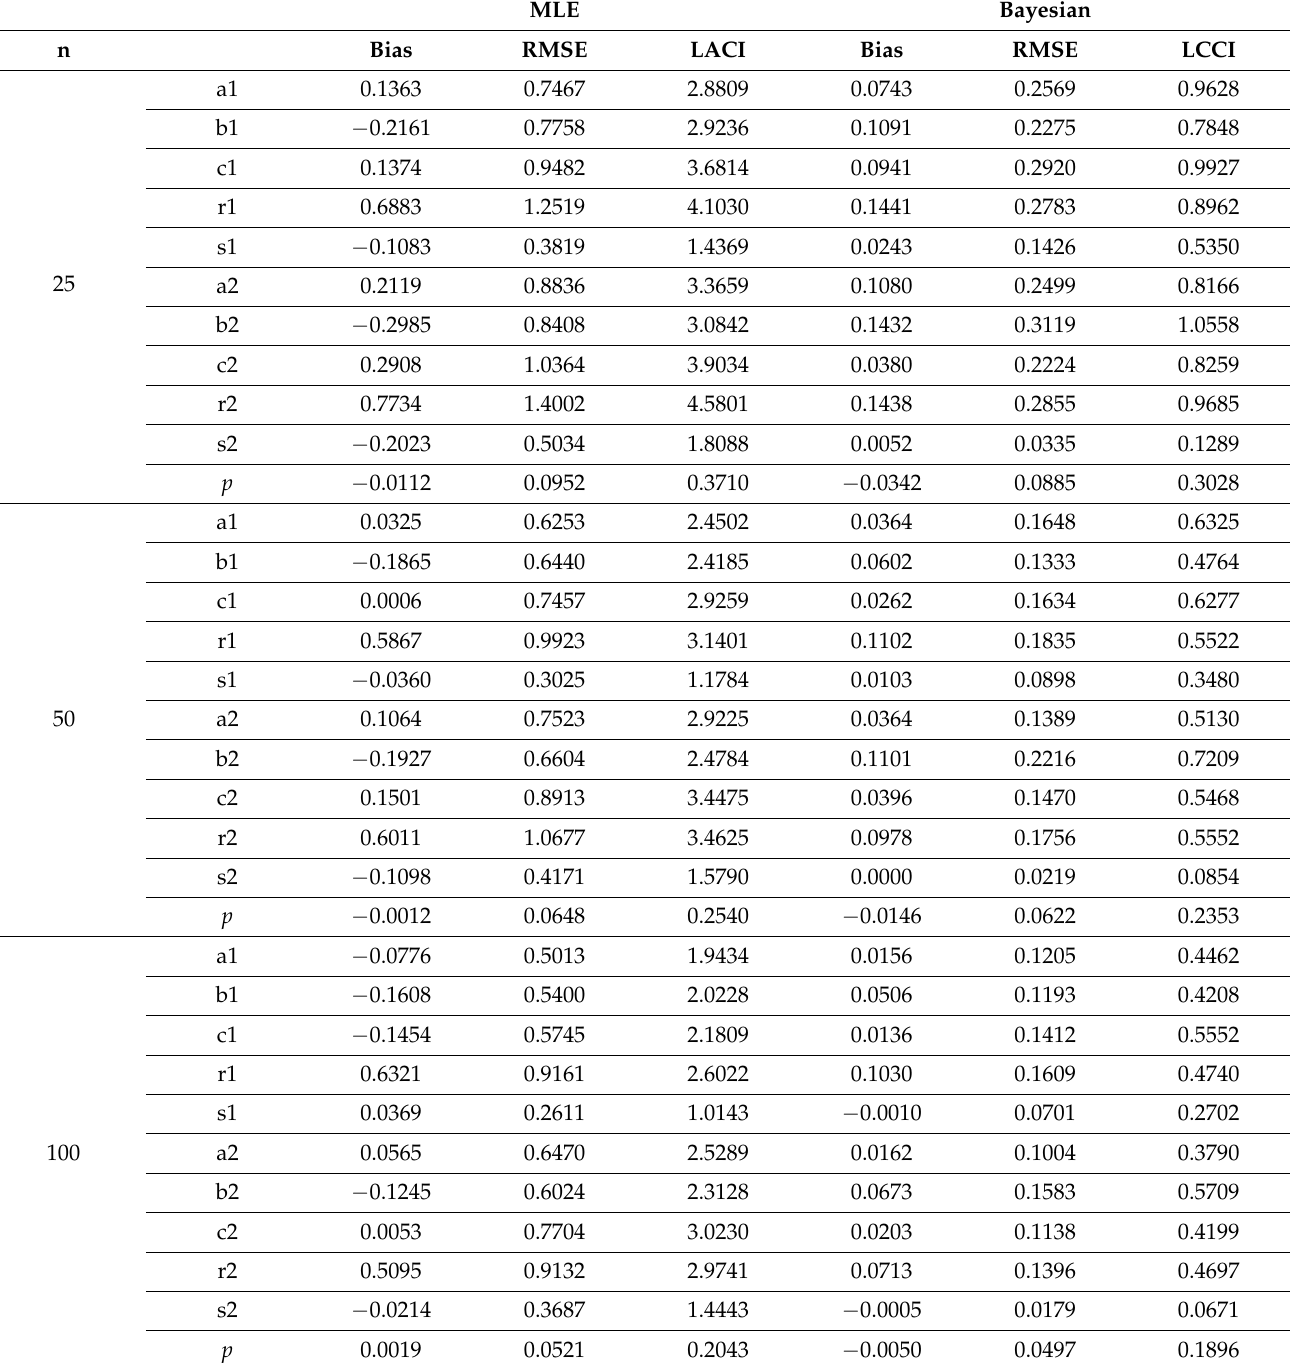
Table 2. Bias, RMSE and length of CI for the MLE and Bayesian estimates of the parameters are presented for different sample sizes: Scheme 1 (complete sample), Case